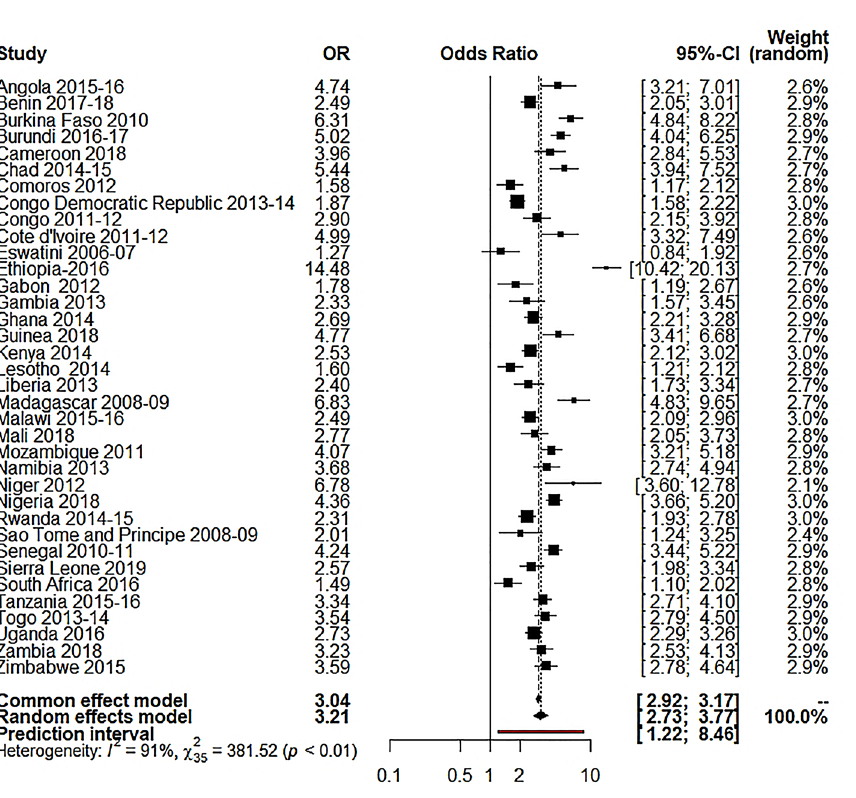
Figure 2. Forest plot for the place of